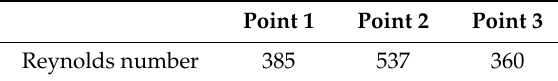
Figure 2. Locations for Reynolds number calculation. Table 1. Reynolds numbers at different locations.